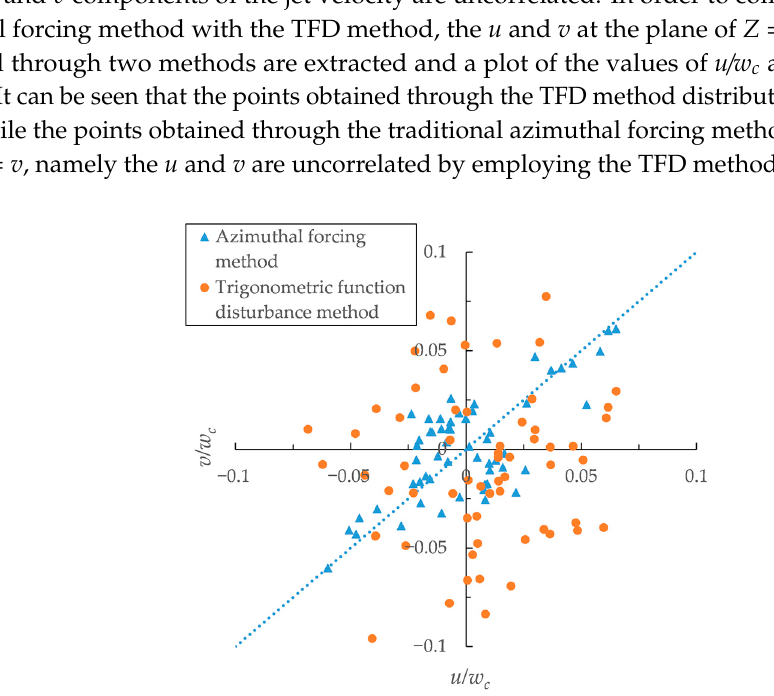
Figure 4. The correlation between u and v at the plane of Z = 20.